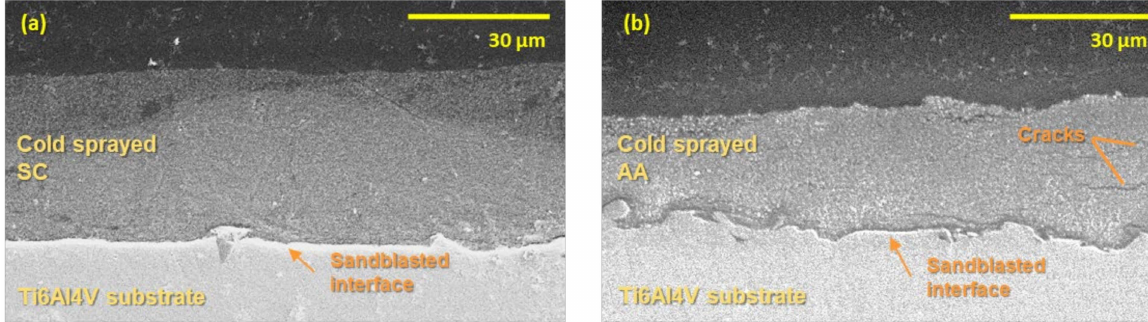
Figure 8. Commercial HA coatings SEM analysis: ( a ) SC coating and ( b ) AA coating.